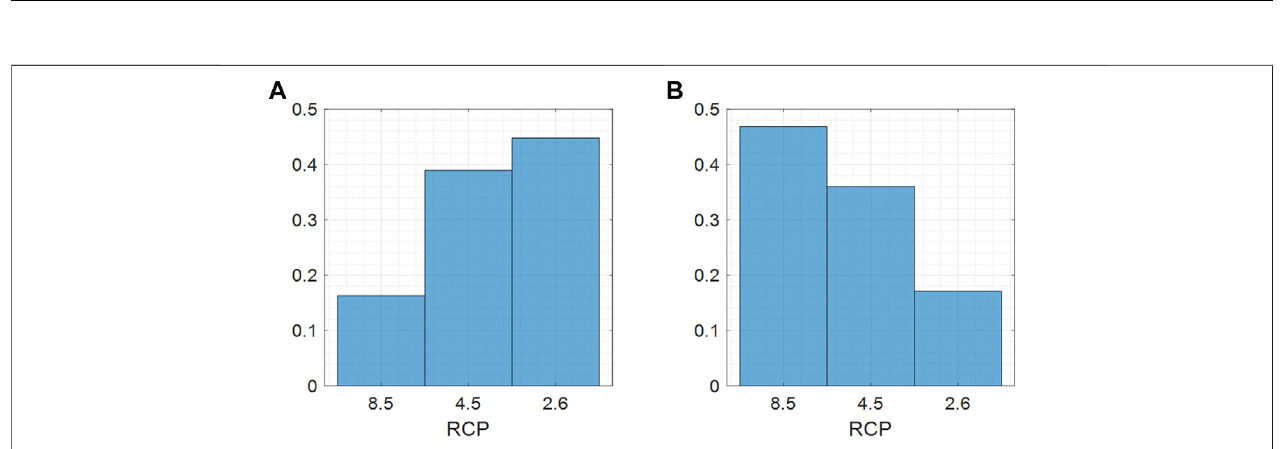
FIGURE 9 | Variation in the posterior distribution of RCP under the two different climate scenarios: (A) moderate, and (B) extreme.